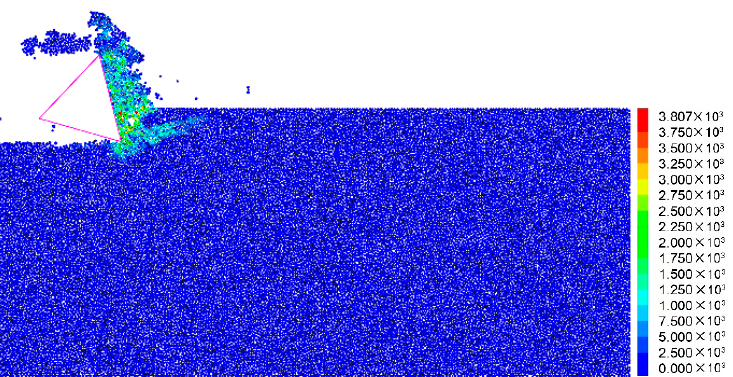
Figure 9. Fluid force applied to particles.